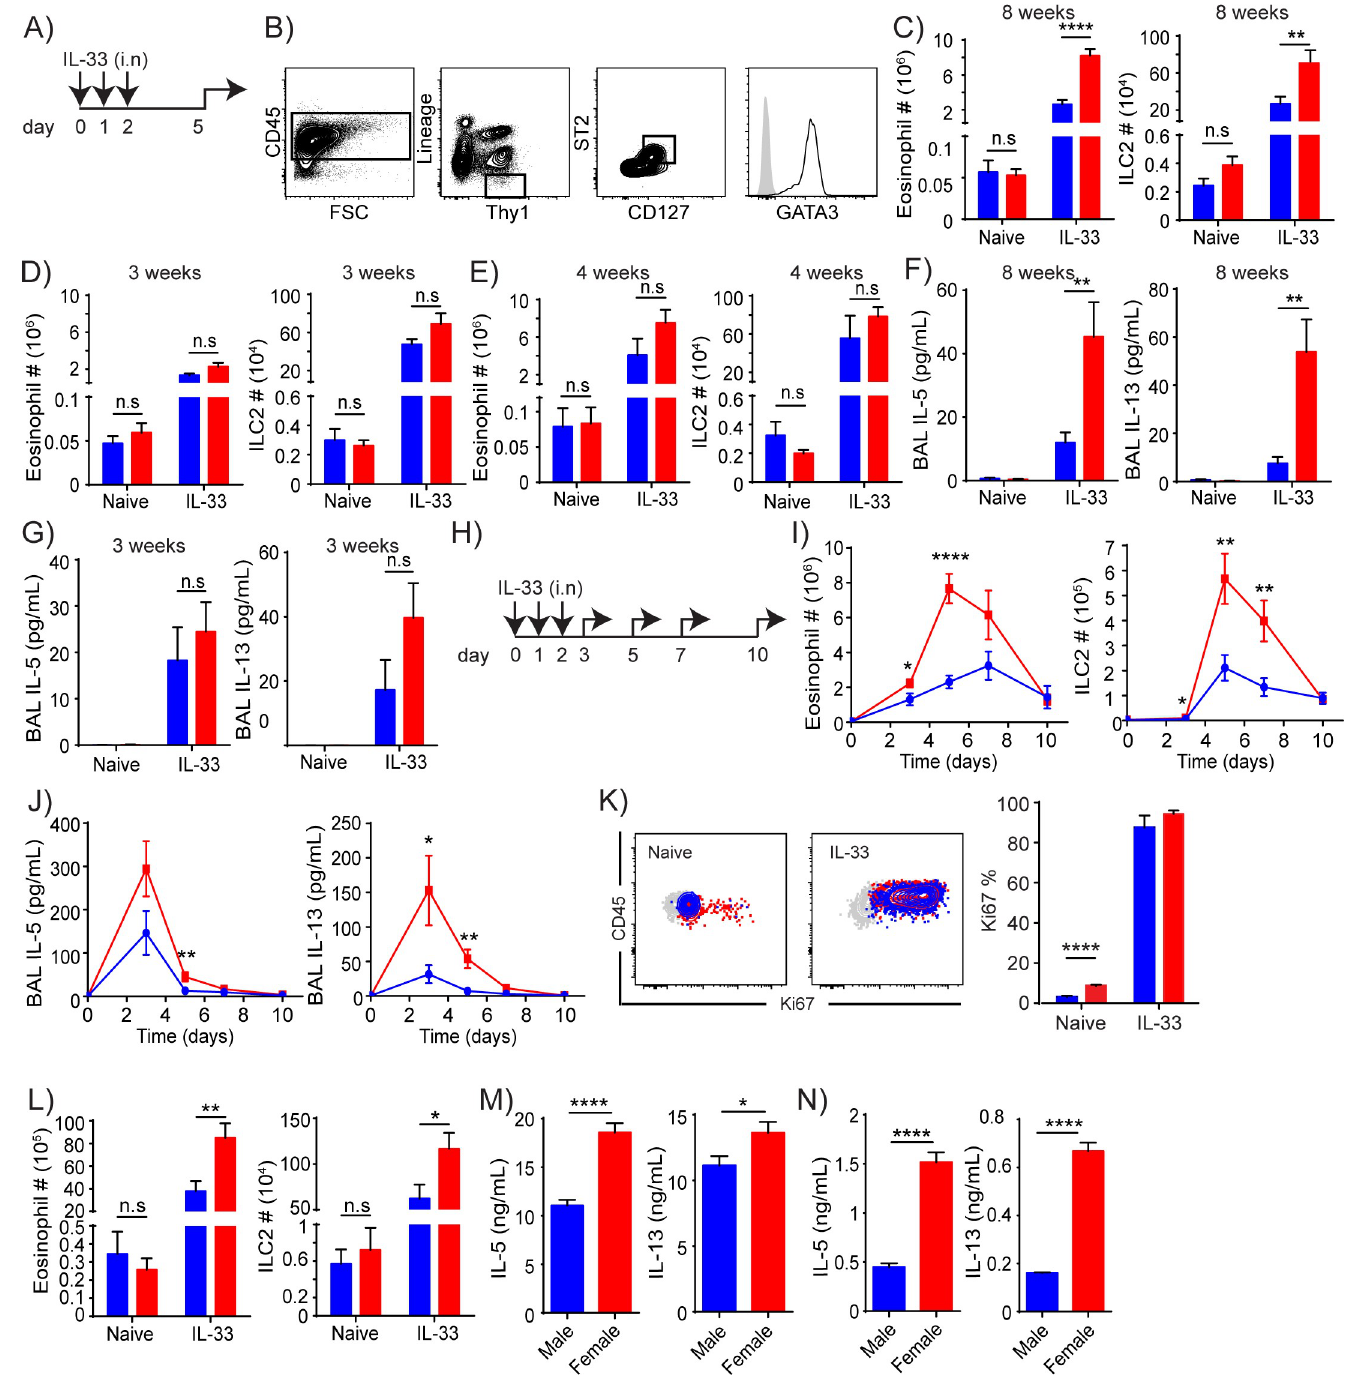
Fig 1. Female ILC2s respond more vigorously to IL-33 stimulation than male ILC2s. (A) Treatment scheme for in vivo experiments. (B) Gating strategy to identify ILC2s. They were identified as Lineage (CD3 ε , CD4, CD19, CD11b, CD11c, TCR β , TCR γδ , NK1.1, Gr1, Ter119) - CD45 + Thy1(CD90) + CD127 + ST2 + cells and confirmed for GATA3 expression. Grey = fluorescence-minus-one control, black line = ILC2. (C-E) Eosinophil and ILC2 numbers in untreated or IL-33 treated 8 week- (C), 3 week- (D) and 4 week- (E) old mice 3 days after 3 consecutive IL-33 injections. (F,G) BALF cytokines in untreated or IL-33 treated 8 week- (F) and 3 week- (G) old mice 3 days after 3 consecutive IL-33 injections. (H) Treatment scheme for in vivo time-course analyses. (I, J) Eosinophil and ILC2 numbers (I) and BALF cytokines (J) were quantified at day 0 (naive) and then 1 day (day 3), 3 days (day 5), 5 days (day 7) and 8 days (day 10) after 3 consecutive IL-33 injections. (K) Ki67 staining of male (blue) and female (red) ILC2s before and 1 day after IL-33 injections. Grey = Isotype control. (L) Eosinophil and ILC2 numbers in untreated or IL-33 treated 8 week-old Rag1 -/- mice 3 days after 3 consecutive IL-33 administrations. (M, N) Amounts of IL-5 and IL-13 in supernatant collected from male or female